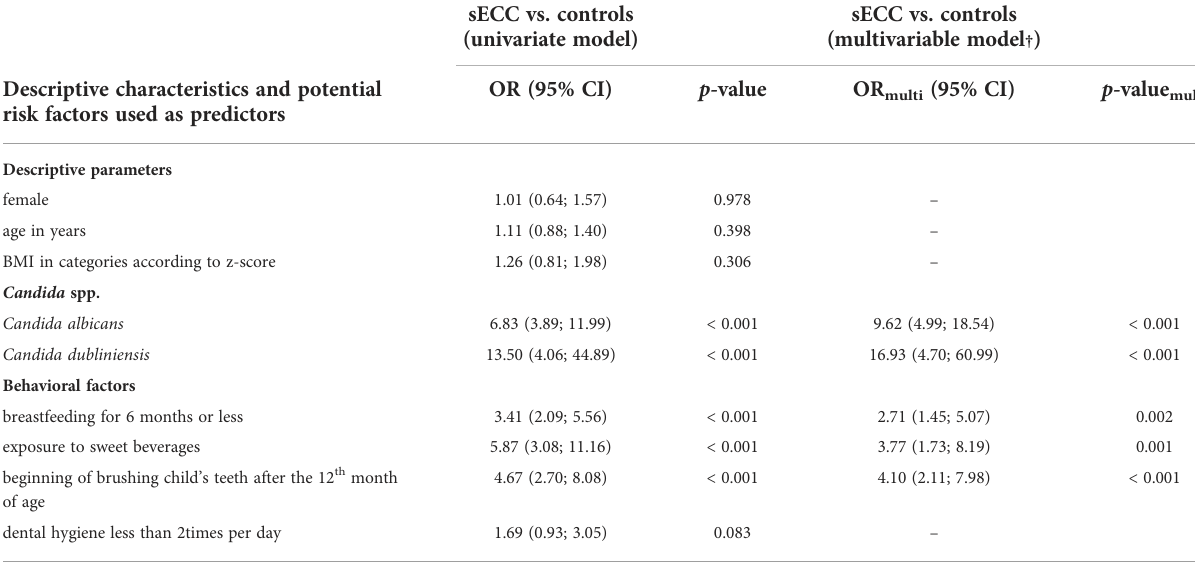
sECC vs. controls (multivariable model †